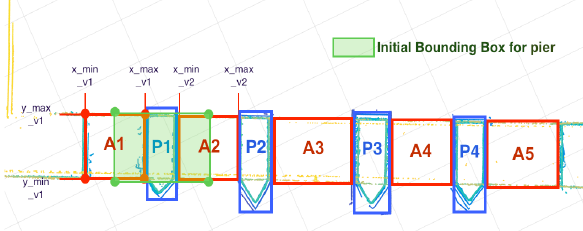
Figure 6. Bounding boxes of structural elements to find pier points.